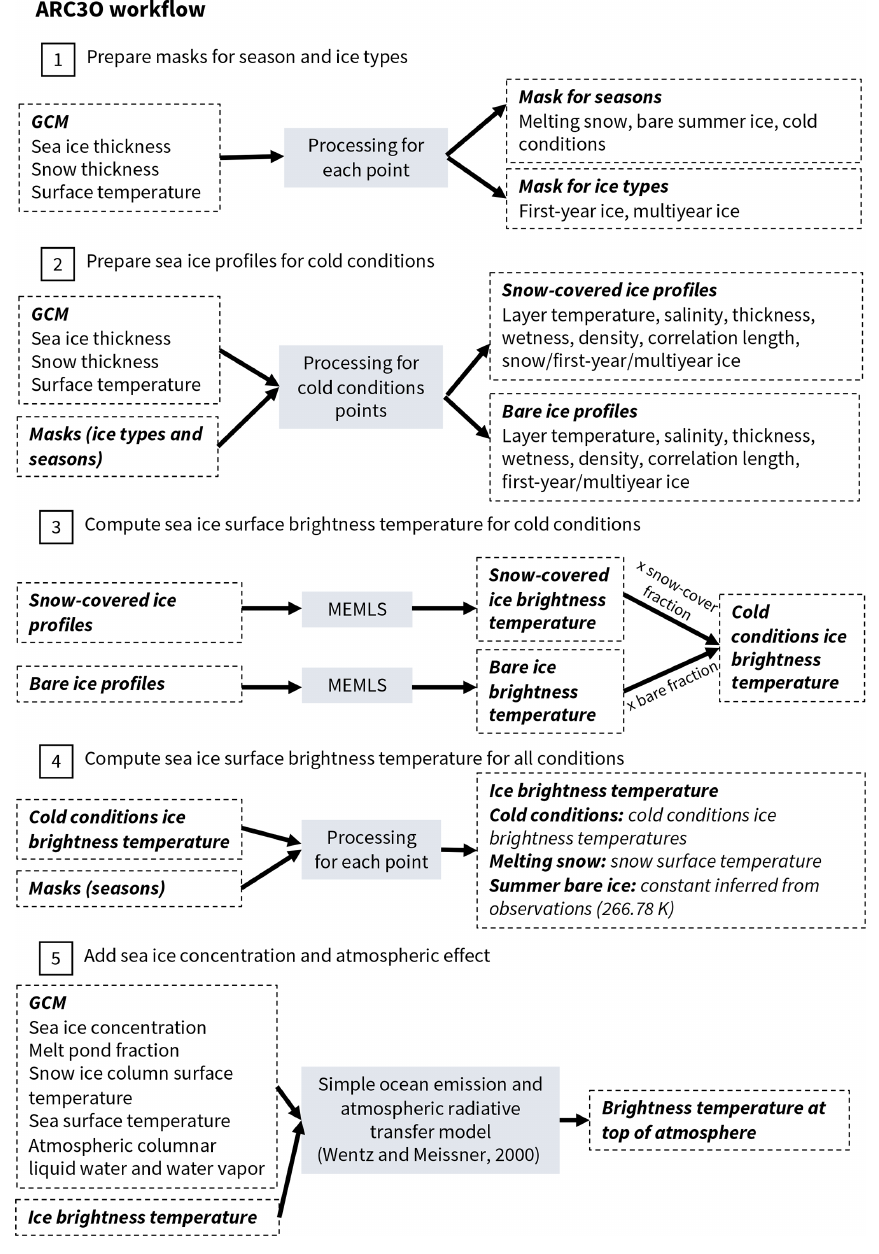
Figure 1. Workflow of the Arctic Ocean Observation Operator